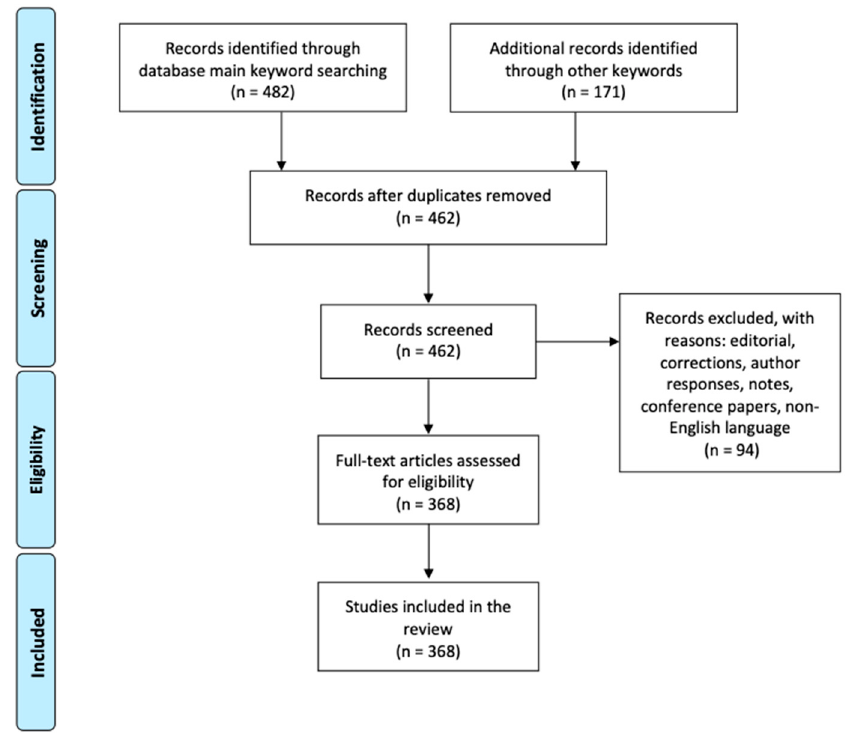
Figure 2. PRISMA flow diagram of the selection process of indicators for assessing research papers on sustainable healthy diets. Main keywords: “healthy and sustainable diet”, “sustainable and healthy diet”, “sustainable diet” and “healthy diet”, “sustainable healthy diet”, “healthy sustainable diet”. Other keywords: see Table 1 (28 February 2021).